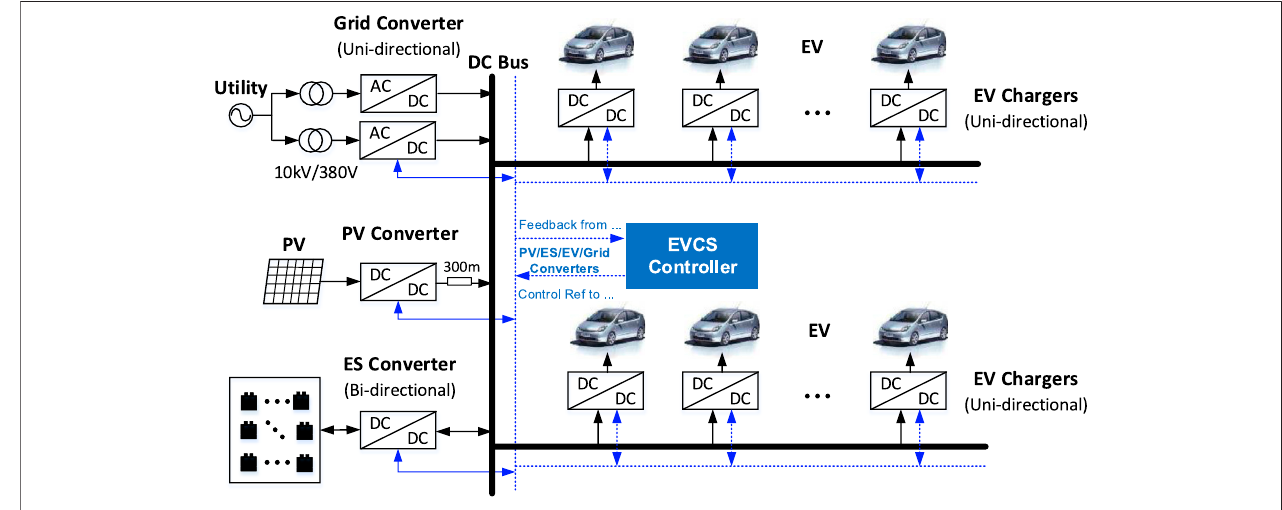
FIGURE 2 | Diagram of integrated electric vehicle (EV) charging